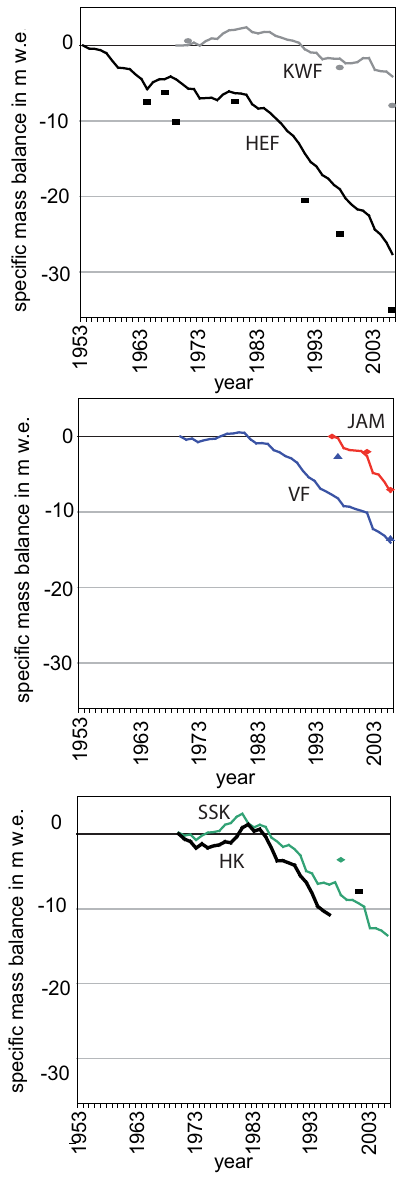
Fig. 7. Cumulative specific mass balance of HEF, KWF, VF, SSK, HK and JAM derived with the direct (lines) and the geodetic (dots)